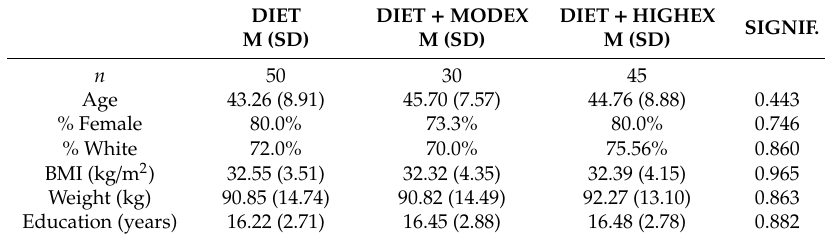
Demographic characteristics of participants by group. Data are presented as mean (standard